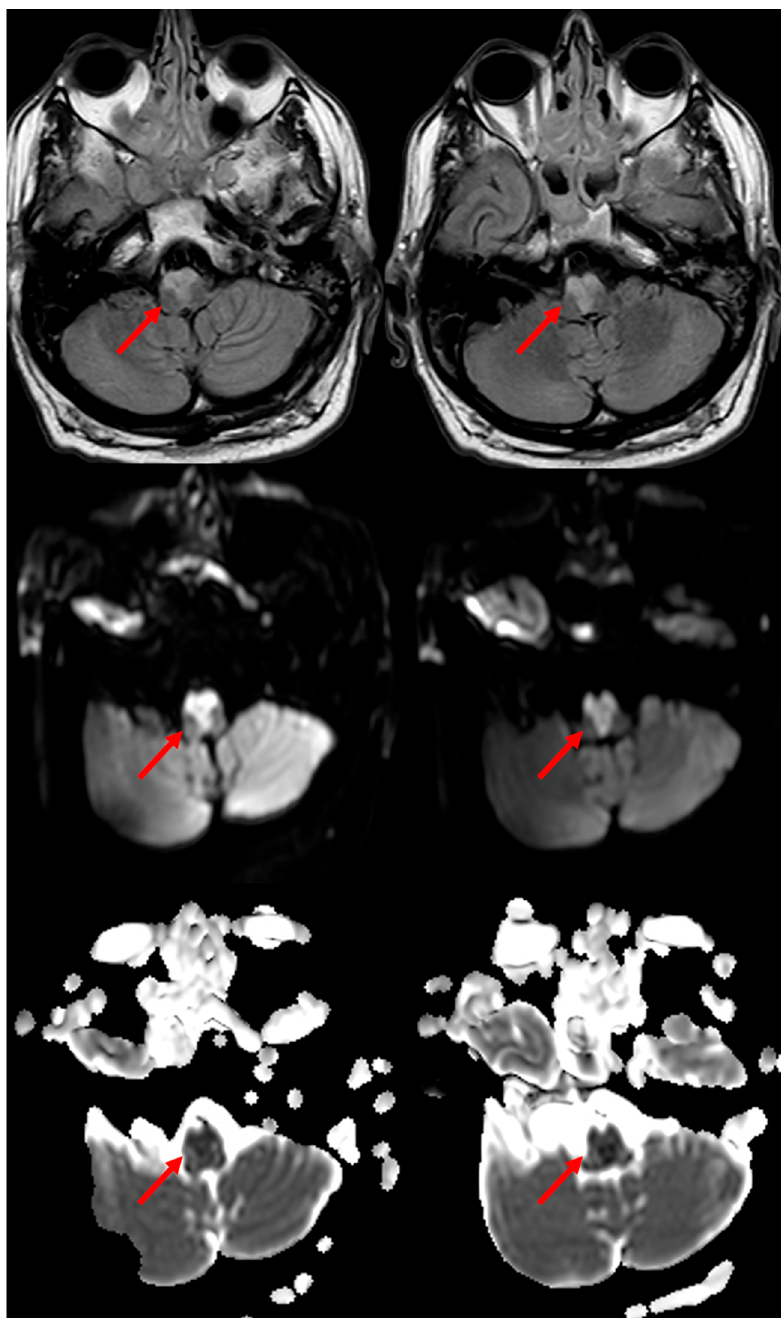
Figure 4. “Heart appearance sign” in acute BMMI, which is well evident in MRI on FLAIR axial images (first row), DWI images (second row) and Apparent Diffusion Coefficient (ADC) images (third row) (red arrows)